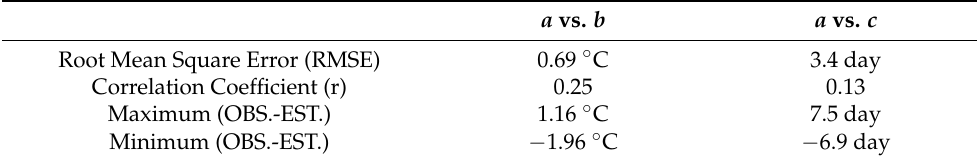
Table 2. Statistics of the linear regression of a vs. b , and a vs. c.